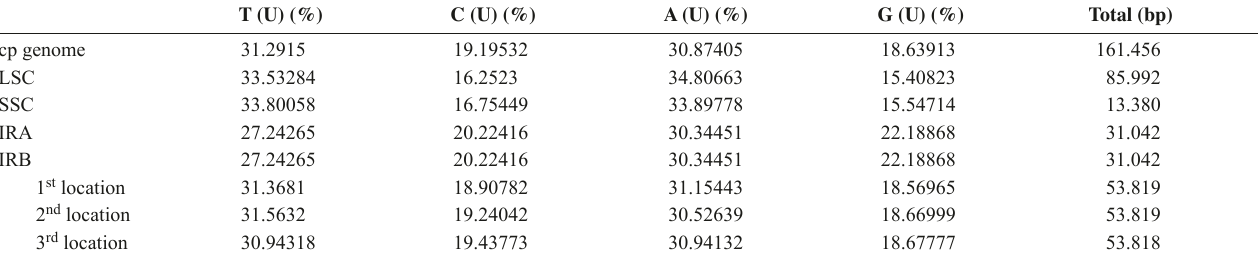
Tab. 1: Caralluma quadrangular cp genome base compositions.